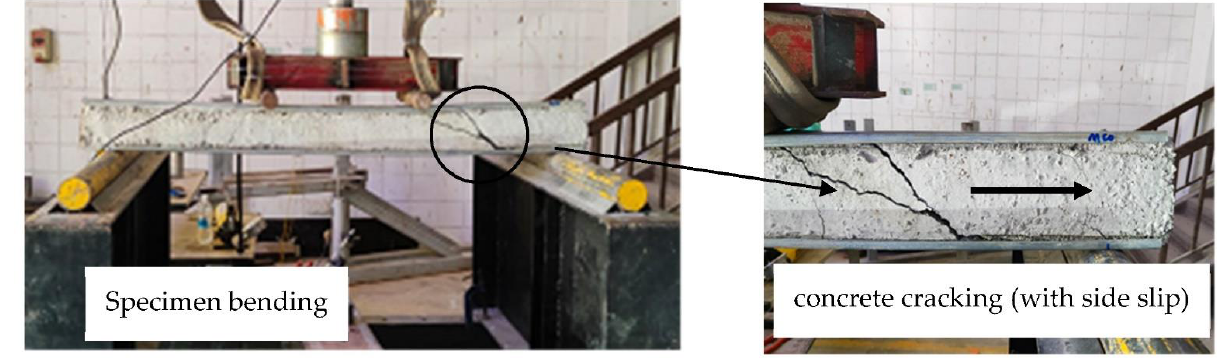
Figure 6. Typical failure modes of C-section specimen filled with normal concrete.